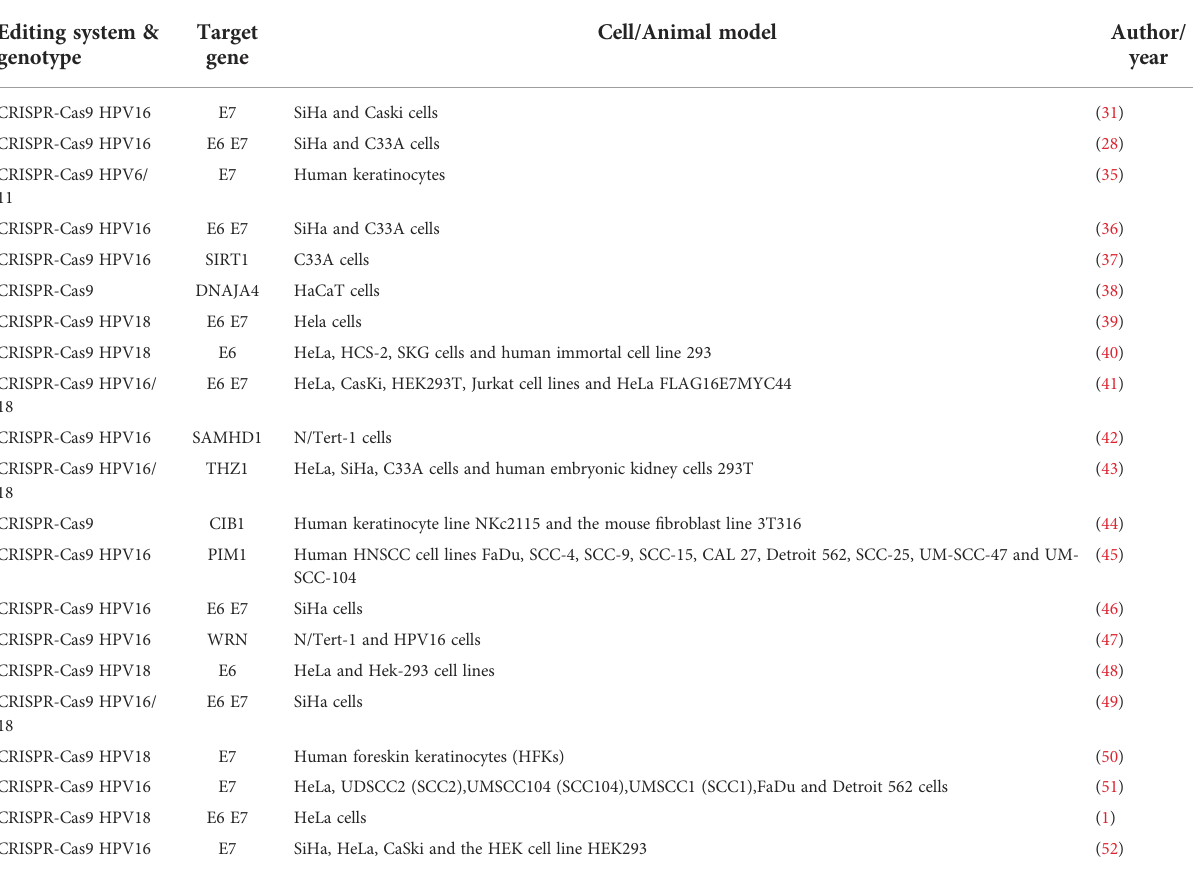
TABLE 1 Summary of studies of CRISPR-Cas9 targeting HPV